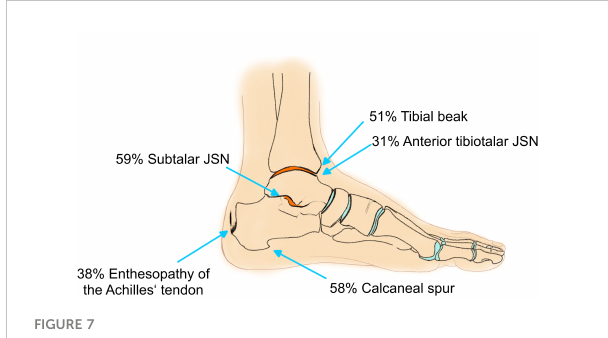
FIGURE 7 Frequency of enthesopathies and moderate to severe JSN of the ankle joint: orange surface indicates predilection sites for